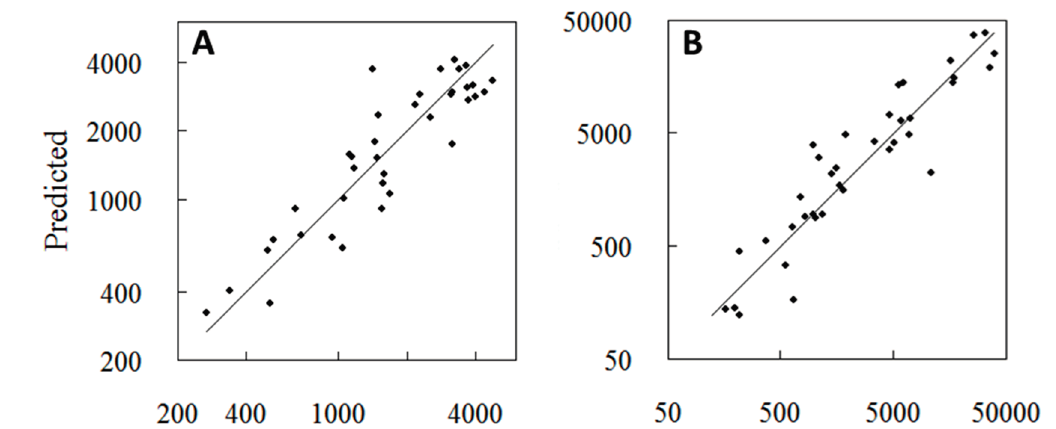
Figure 5. Scatterplots of observed (validation subset) versus predicted aboveground wet biomass using the multiple-band vegetation indices shaded in gray from Table 2 for rice ( A ); alfalfa ( B ); cotton ( C ); and maize ( D ). The diagonal line represents a 1:1 relationship. With the exception of alfalfa, which is built on 1st order derivative transformed spectra, equations are built on the untransformed